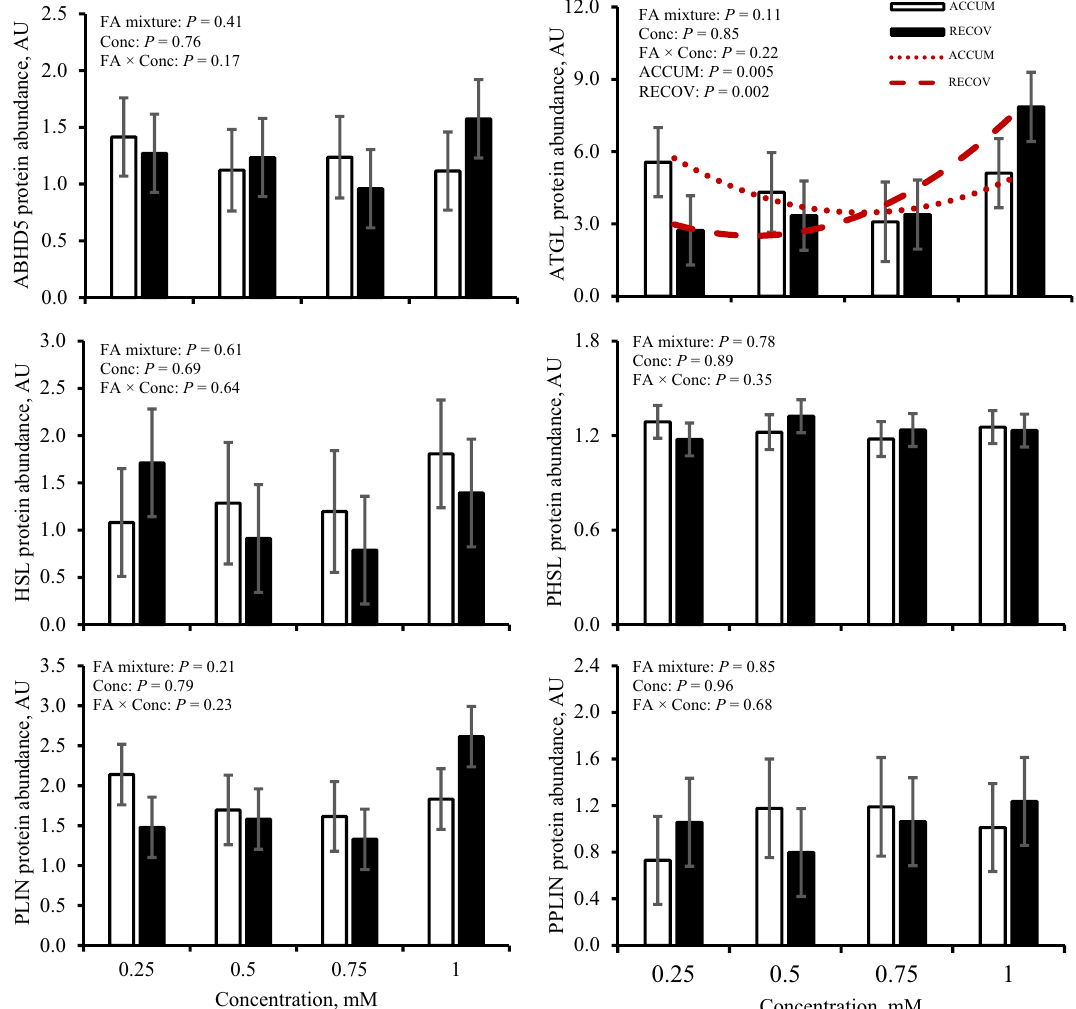
Figure 3. Protein abundance of abhydrolase domain containing 5 (ABHD5), adipose triglyceride lipase (ATGL), hormone sensitive lipase (HSL), phosphorylated HSL (PHSL), perilipin (PLIN), and phosphorylated PLIN (PPLIN) in response to fatty acid mixture representing liver lipid accumulation (ACCUM; open bars and dotted line) and fatty acid mixture representing liver lipid clearing (RECOV; closed bars and dashed line) at different concentrations in primary bovine hepatocytes. Data is presented as least squares mean ± standard error of the means. Quadratic relationships are displayed if P ≤ 0.15 for a main